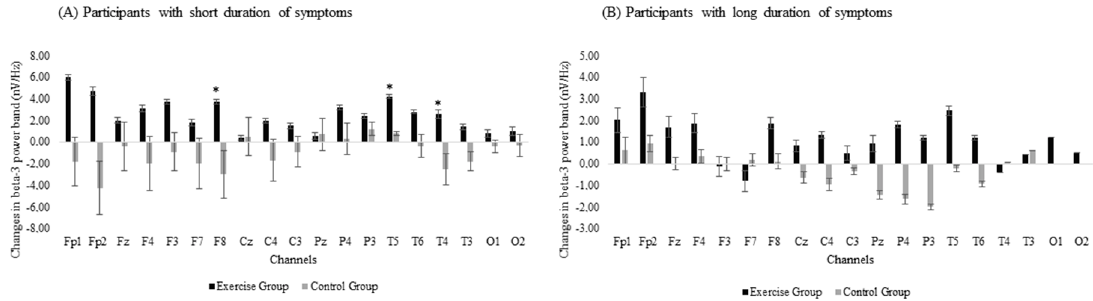
Figure 3. Changes in beta-3 band power for subgroups with ( A ) short duration or ( B ) long duration of symptoms. Error bars represent the standard error of the mean. *: Significant differences ( p < 0.05) between the exercise and the control groups after the exergames intervention.